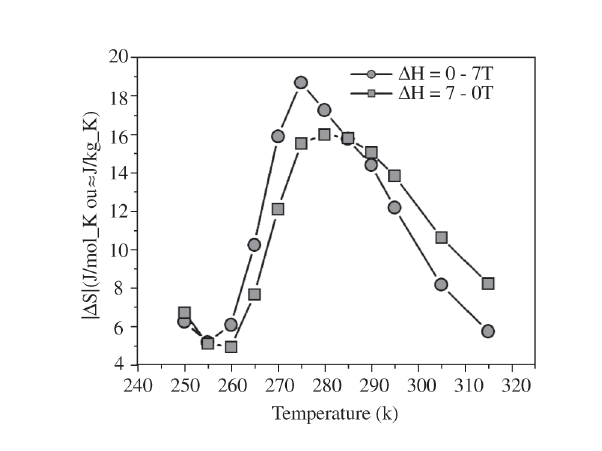
Ge Si alloy. 5 2 2